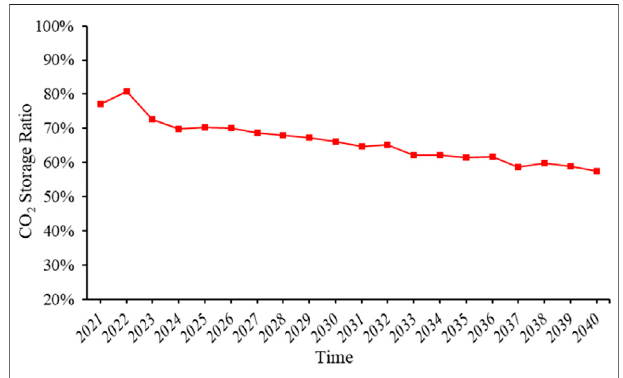
FIGURE 15 | Annual CO 2 storage ratio under the best injection